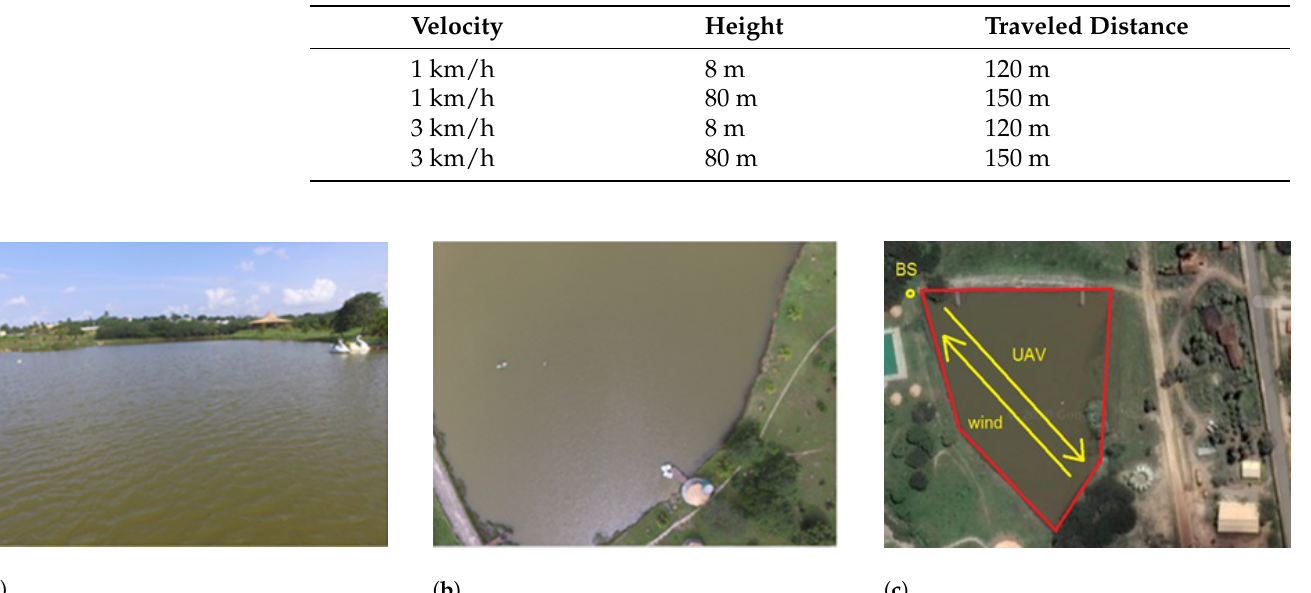
Table 3. Scenario 1 parameters.